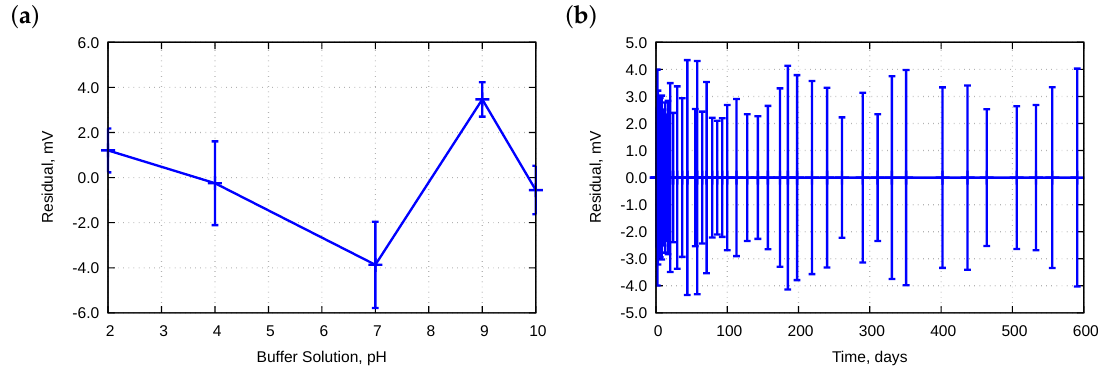
Figure 8. Averaged residuals obtained during approximation to the Nernst equation for electrode E12 as a function of: ( a ) pH; and ( b ) lifetime. Bars mean standard deviations.